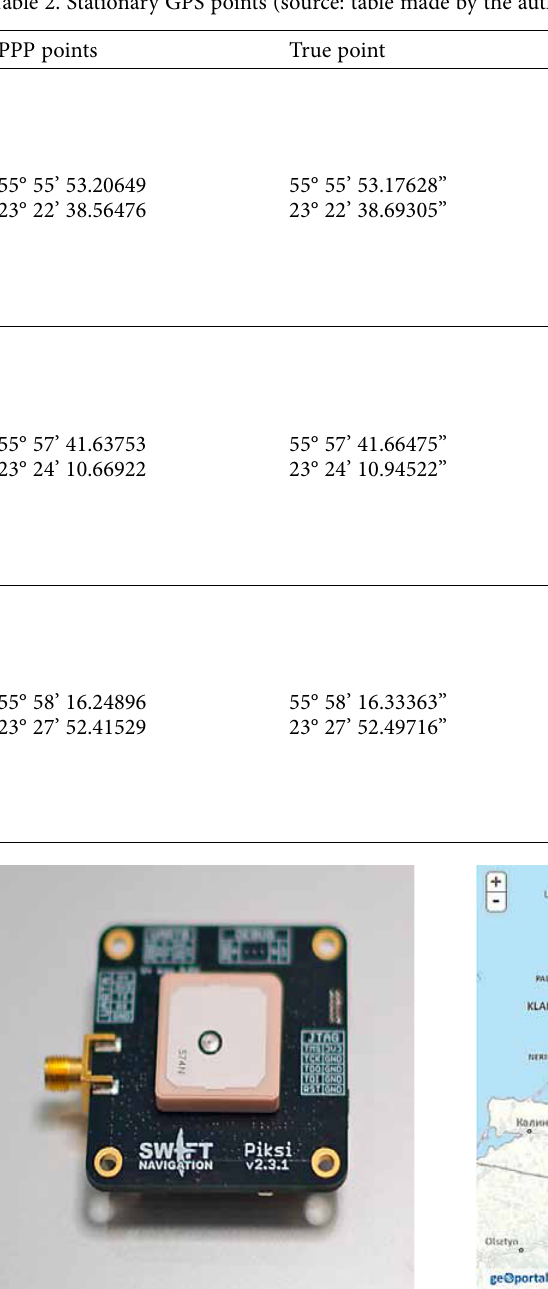
Fig. 3. Swiftnav ,,Piksi” module (source: figure made by the authors)